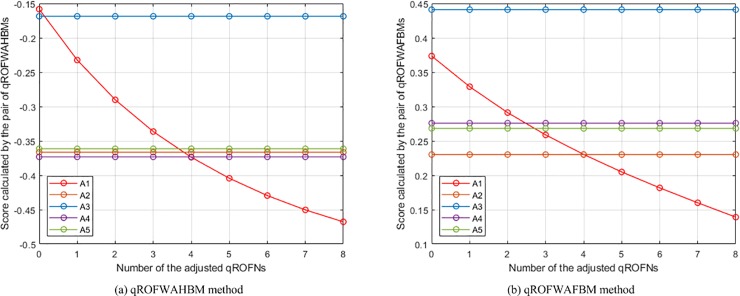
The changes of the places of A1 in the rankings of the WABM method.